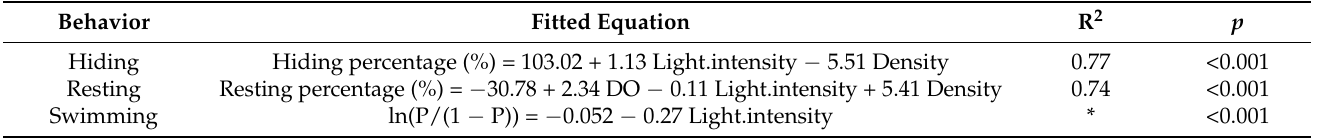
Figure 3. Correlation of shrimp behavior type with water quality, light intensity, and density. Red signifies a positive correlation and blue signifies a negative correlation. The darker the color and the larger the circle, the greater the correlation. Table 1. Results of the model between the behavior and key